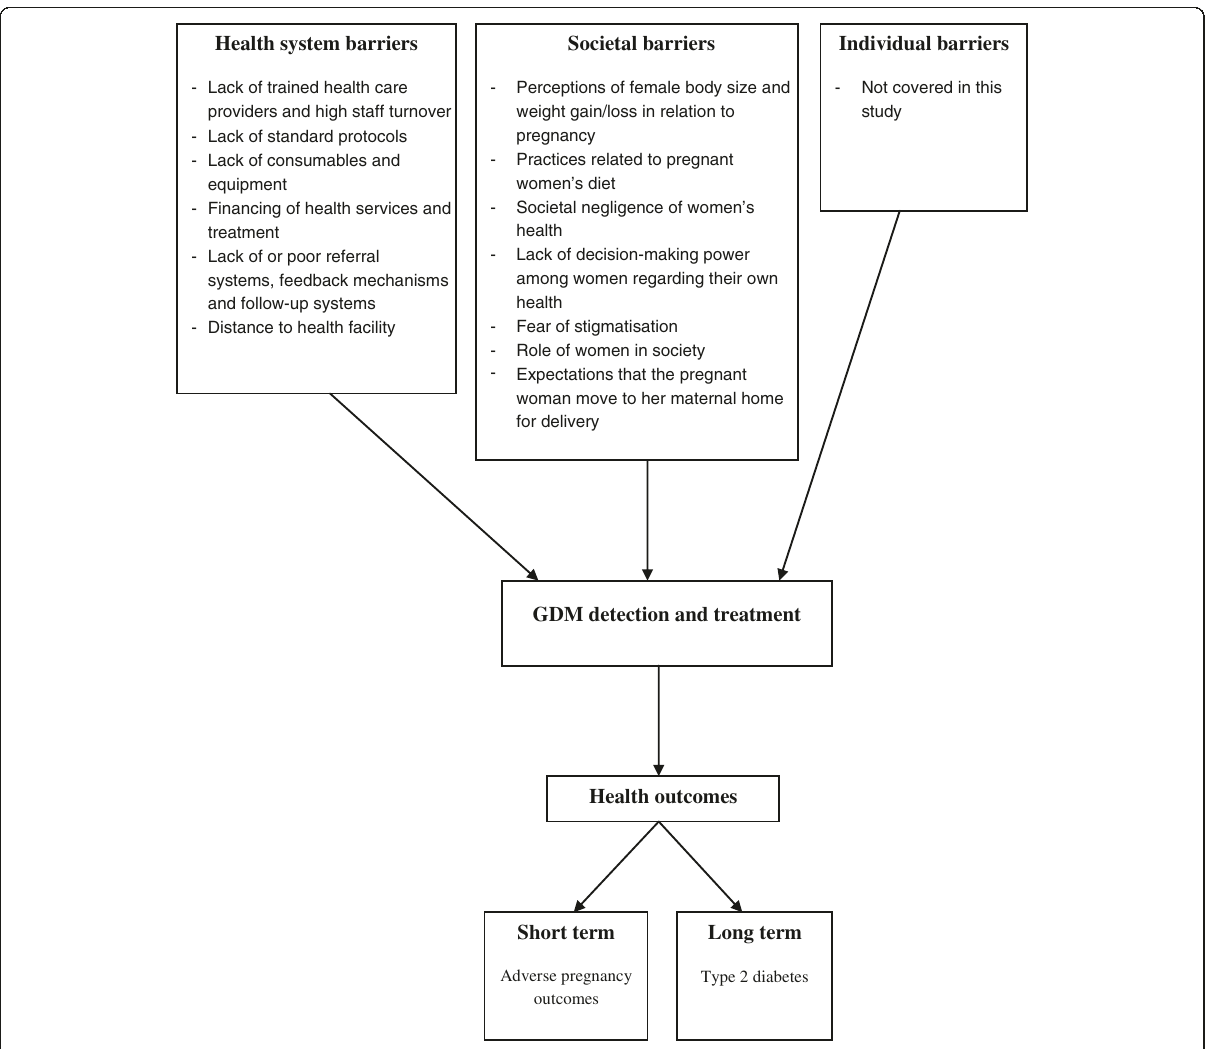
Figure 1 Overview of health system and societal